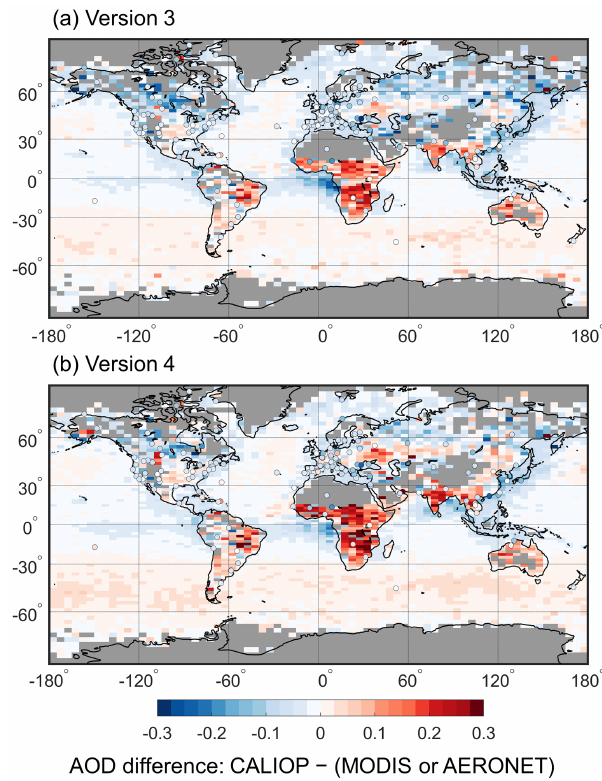
Figure 16. Global maps of mean AOD difference between CALIOP and MODIS. CALIOP data for (a) V3 and (b) V4 and MODIS collection 6 from 2007 to 2009. Mean AOD difference between CALIOP and AERONET is shown in